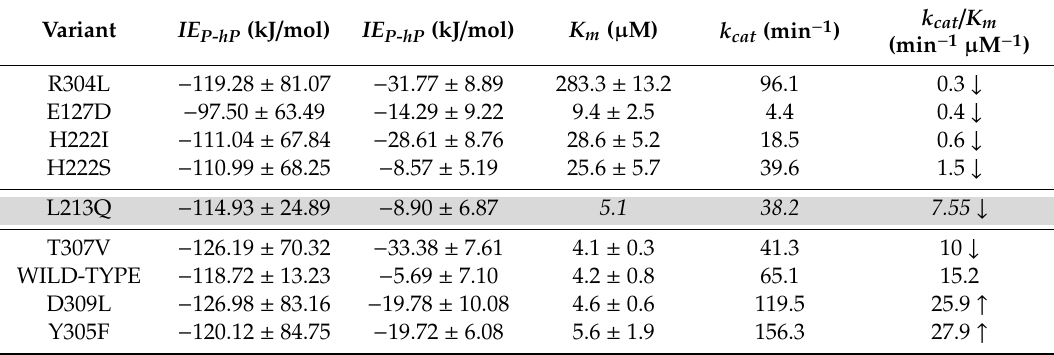
Table 2. Overview of the MD-derived energetic descriptors and the functional descriptors of AKR1C1 variants. IE P-hP is the interaction energy between protein and hPGS, IE N-hP is the interaction energy between NADP + and hPGS. The novel L213Q variant is highlighted in grey, ↓ and ↑ represent values lower and higher than the WILD-TYPE,